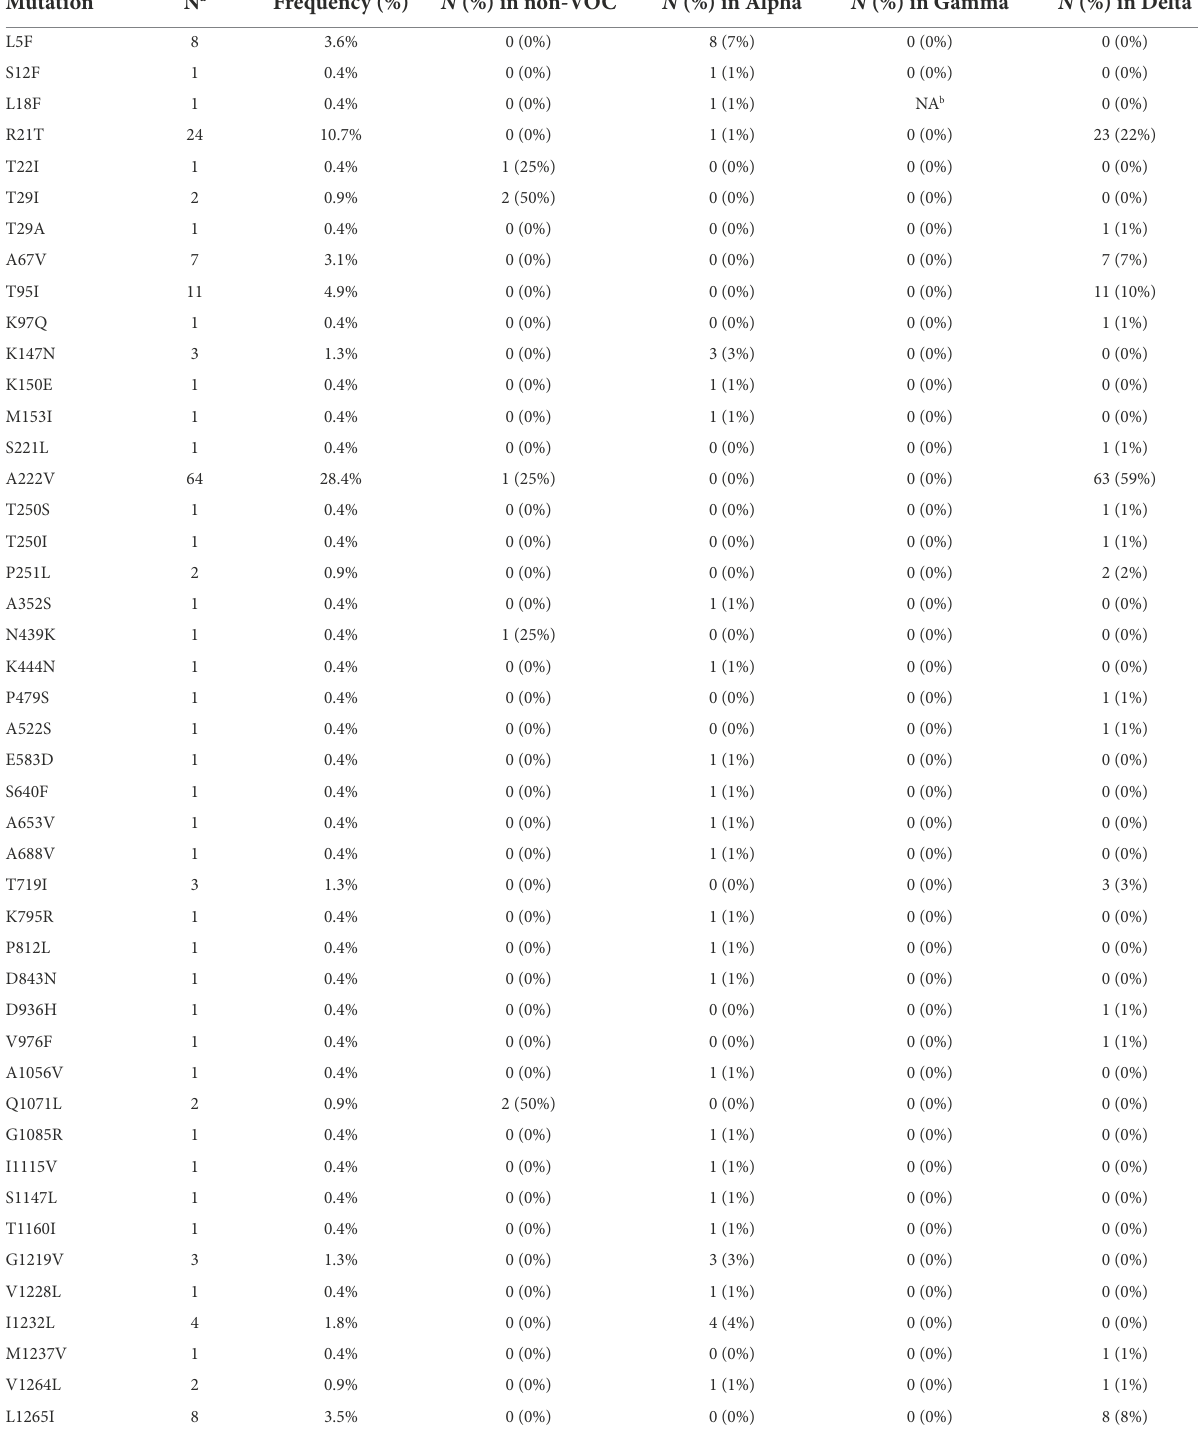
TABLE 3 Non-lineage-defining mutations in the spike protein found in this